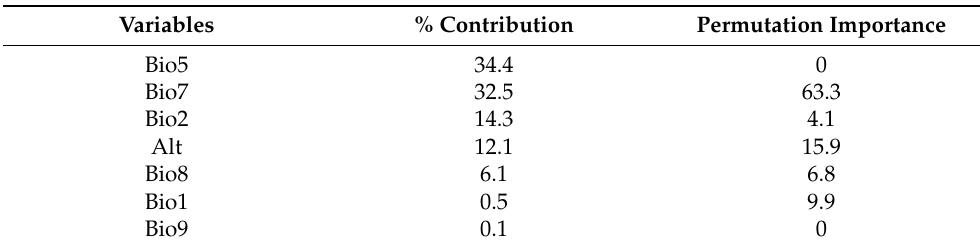
Table 2. Percent contributions of the bioclimatic and topographic variables in the Maxent models for Spogostylum ocyale (10 replicated runs).